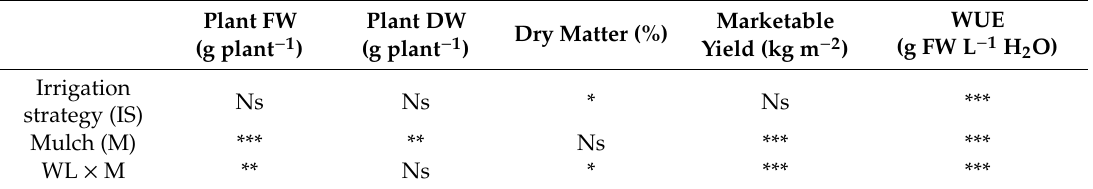
Table 6. Experiment 2: E ff ect of irrigation strategy and soil mulching on the productive parameters of lettuce. Significance codes: *, significant at p ≤ 0.05; **, significant at p ≤ 0.01; ***, significant at p ≤ 0.001, “Ns” = not significant. FW = fresh weight; DW = dry weight; WUE = Water use e ffi ciency. Plant